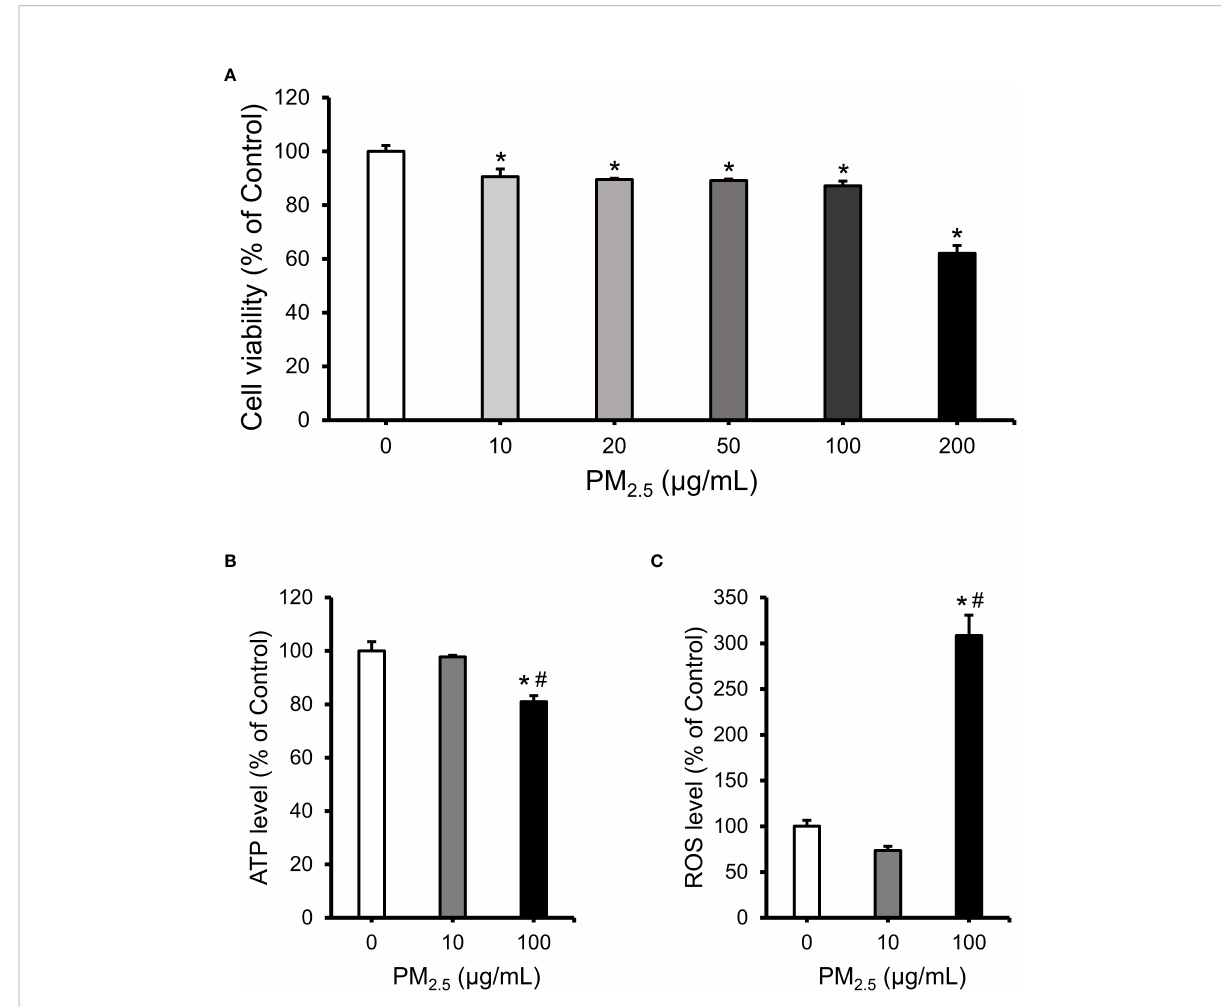
FIGURE 1 Evaluation of cell viability, intracellular ATP concentration, and ROS level in PM 2.5 -treated HL-1 cells. (A) Cell viability of HL-1 cells treated with PM 2.5 (0, 10, 20, 50, 100, and 200 m g/mL) for 12 h. (B) The relative intracellular ATP levels in PM 2.5 -treated cells. (C) The relative intracellular ROS level in PM 2.5 -treated cells. Each data is shown from independently performed triplicate experiments. * p -value < 0.05 vs. control; # p -value < 0.05 vs. 10 m g/mL PM 2.5 -treated